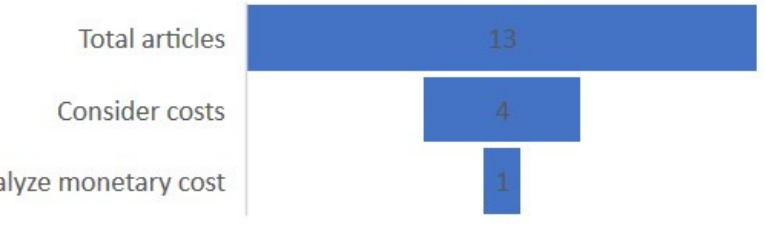
Figure 3. Funnel for cost analysis in articles.